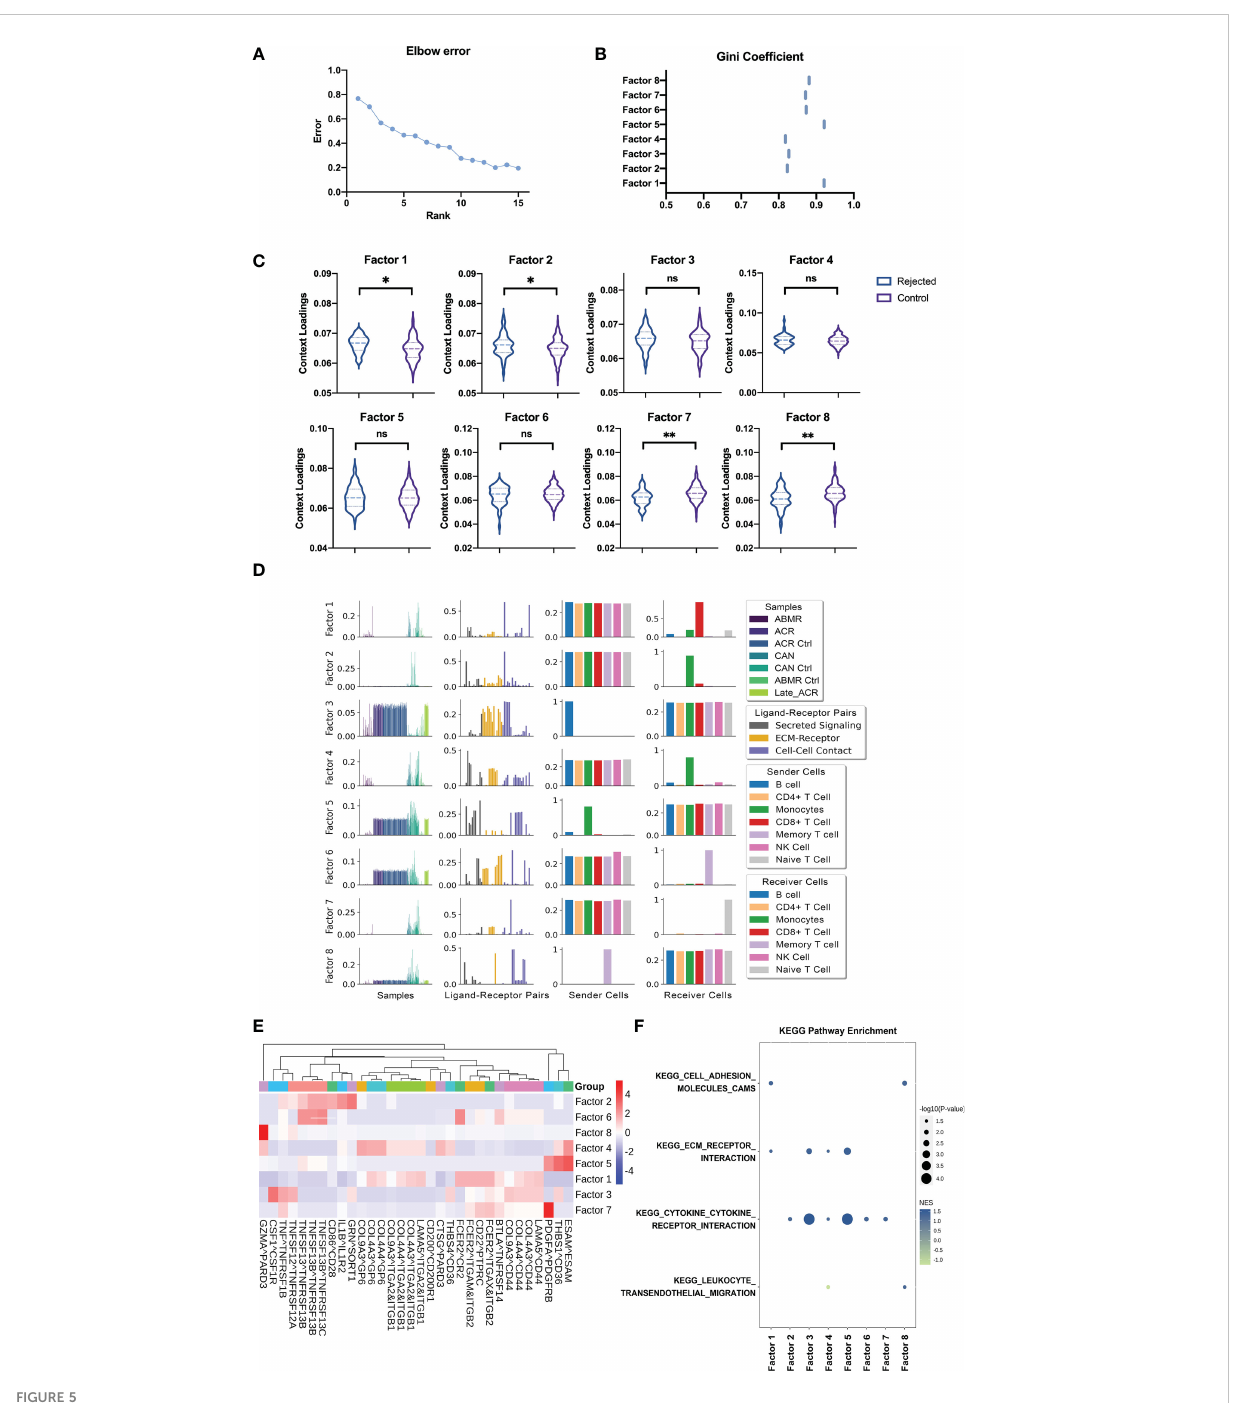
FIGURE 5 Cell-Cell communication analysis from deconvolution matrix of PBMC RNA sequences. (A) The elbow error curve shows the rank number (also represents the number of factors) corresponding to the supervised machine learning ef fi ciency. (B) The Gini coef fi cient quanti fi es the dispersion of the edge weights in each factor cell communication network (also represents the imbalance of communication). (C) Boxplot shows the sample loadings in each of the factors for rejected and control groups of samples. (D) Factors by decomposing the tensor from the deconvolution gene expression level of rejected and control patients computing above were selected for the analysis to show the representing dimension in samples, LR pairs, sender cells, and receiver cells. (E) Heatmap of the ligand-receptors pairs across factors for integration of the samples, shows the major ligand-receptors pairs contributing to the factors. (F) GSEA using the KEGG pathways performed on the LR pairs in each factor. GSEA, Gene Set Enrichment Analysis. "ns" means “ not signi fi cant ” . *p < 0.05 **p <